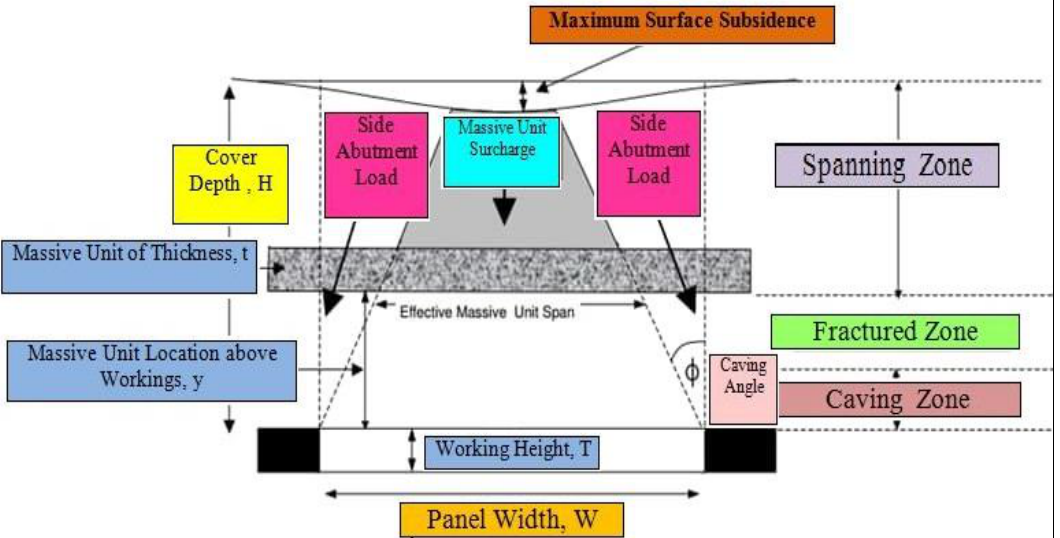
Figure 6: Key parameters of ACARP subsidence prediction method.